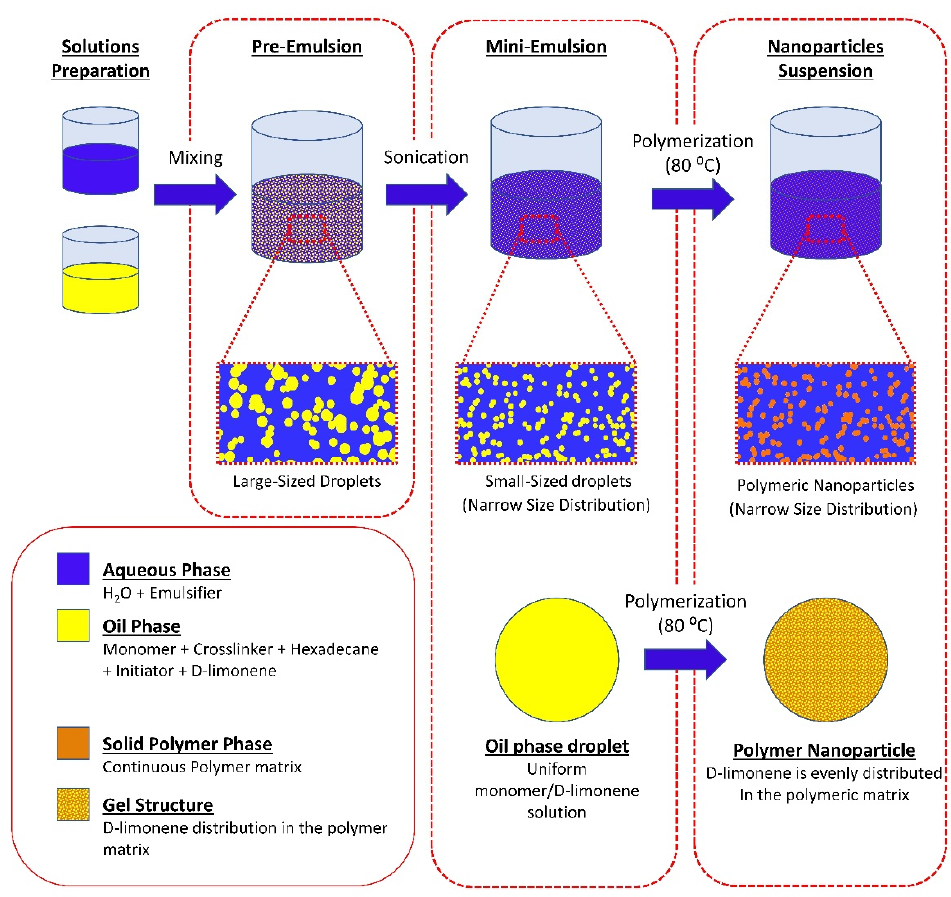
Figure 1. Schematic representation of the mini-emulsion polymerization process, and the possible structure of the synthesized nanoparticles.